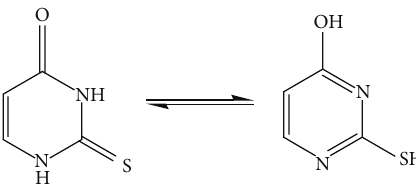
Scheme 1: Chemical structure of